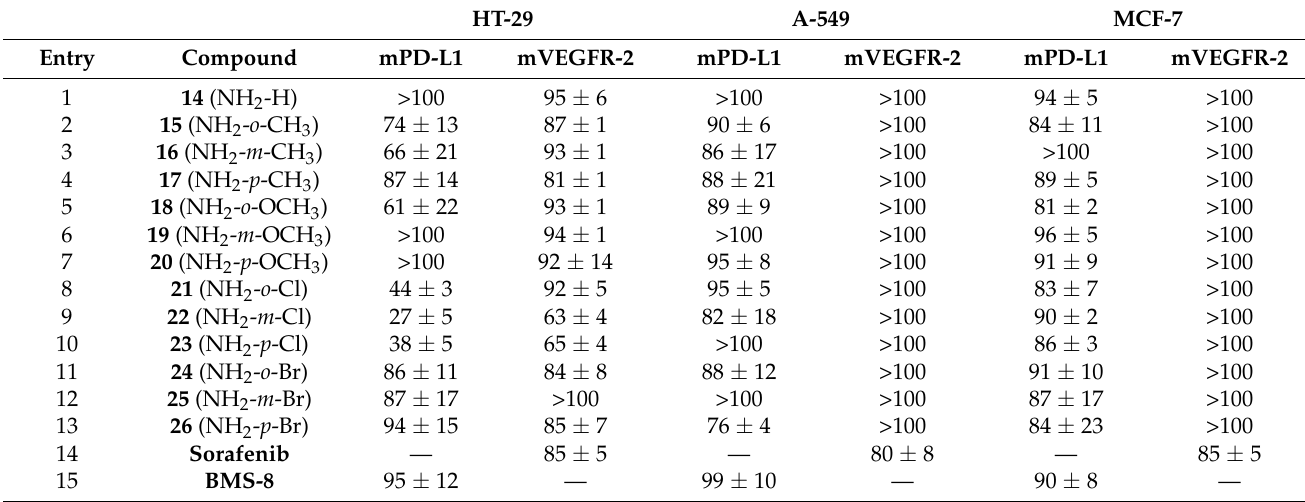
Table 2. Membrane PD-L1 and VEGFR-2 protein relative detection on HT-29, A-549, and MCF-7 cell lines for compounds 14–26 , BMS-8, and sorafenib 1